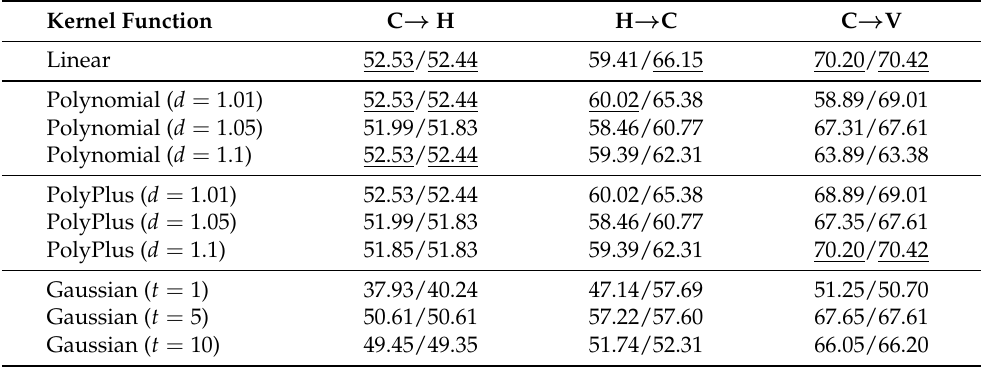
Table 4. The results of cross-database MER experiments by using TKRM with different kernel functions. The best result in each experiment is